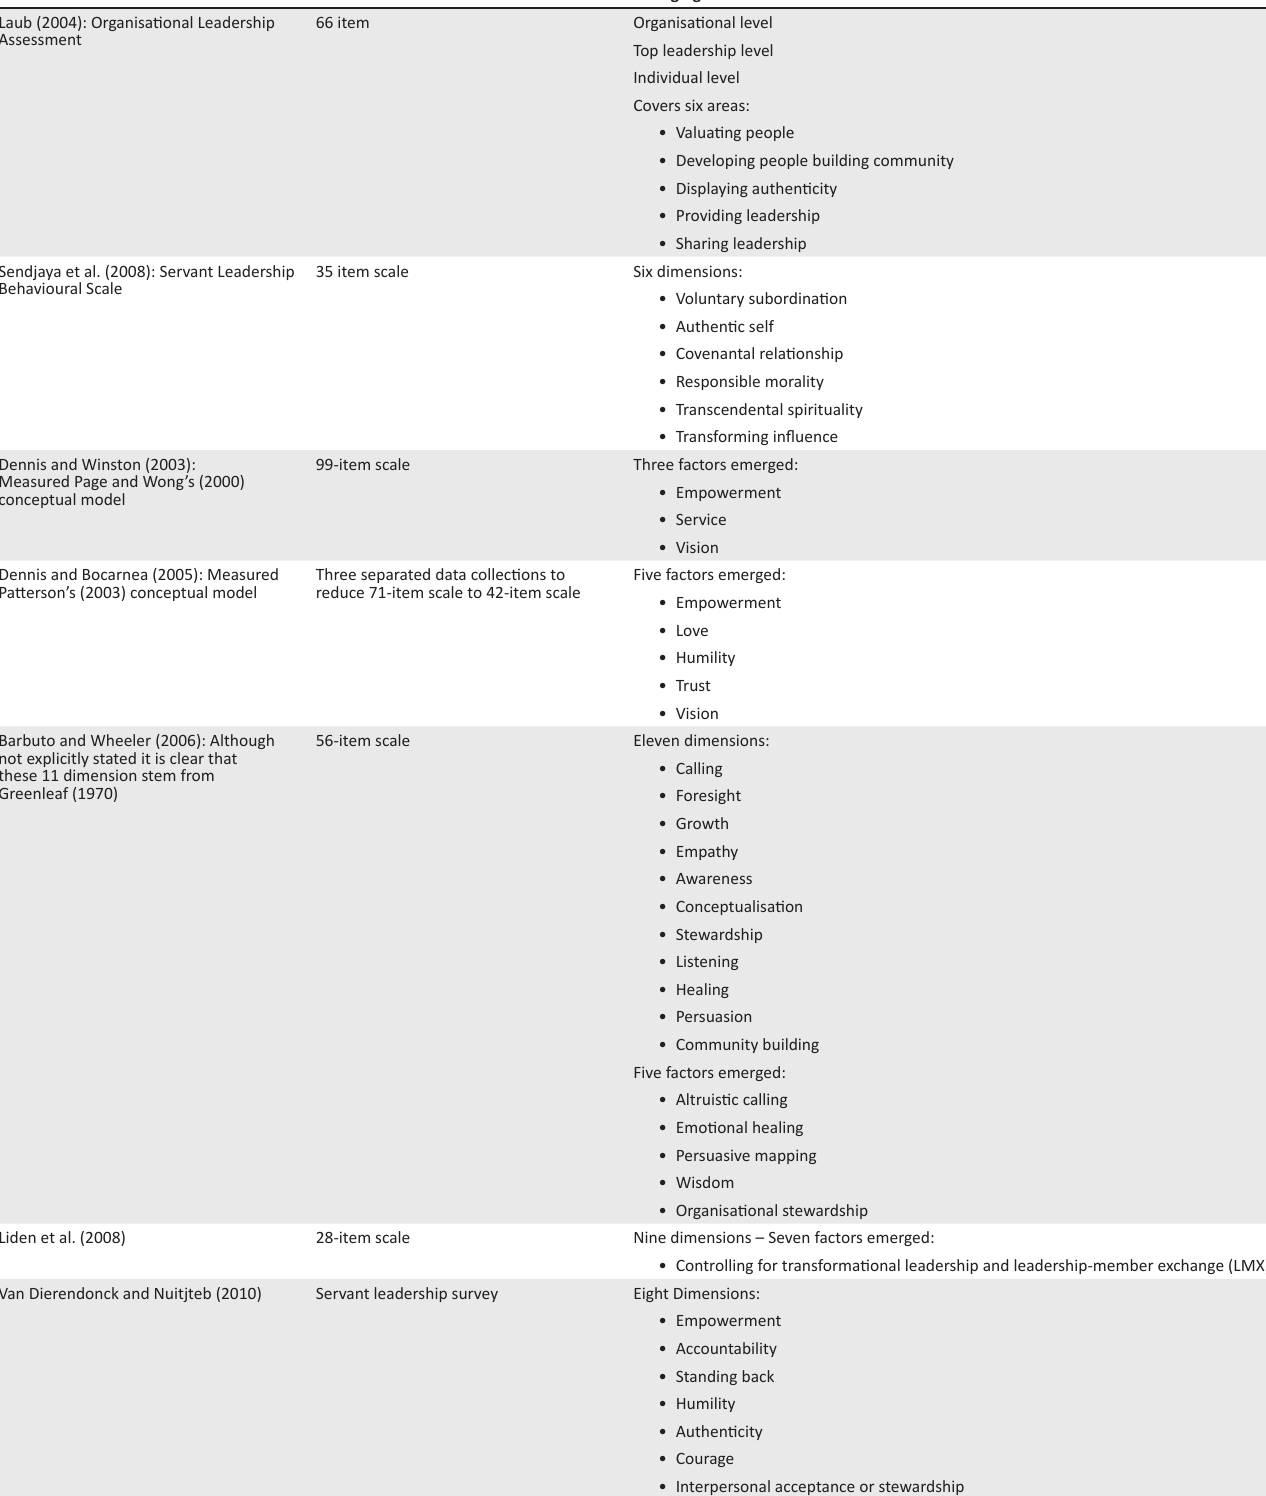
TABLE 1: Servant-as-leader measuring